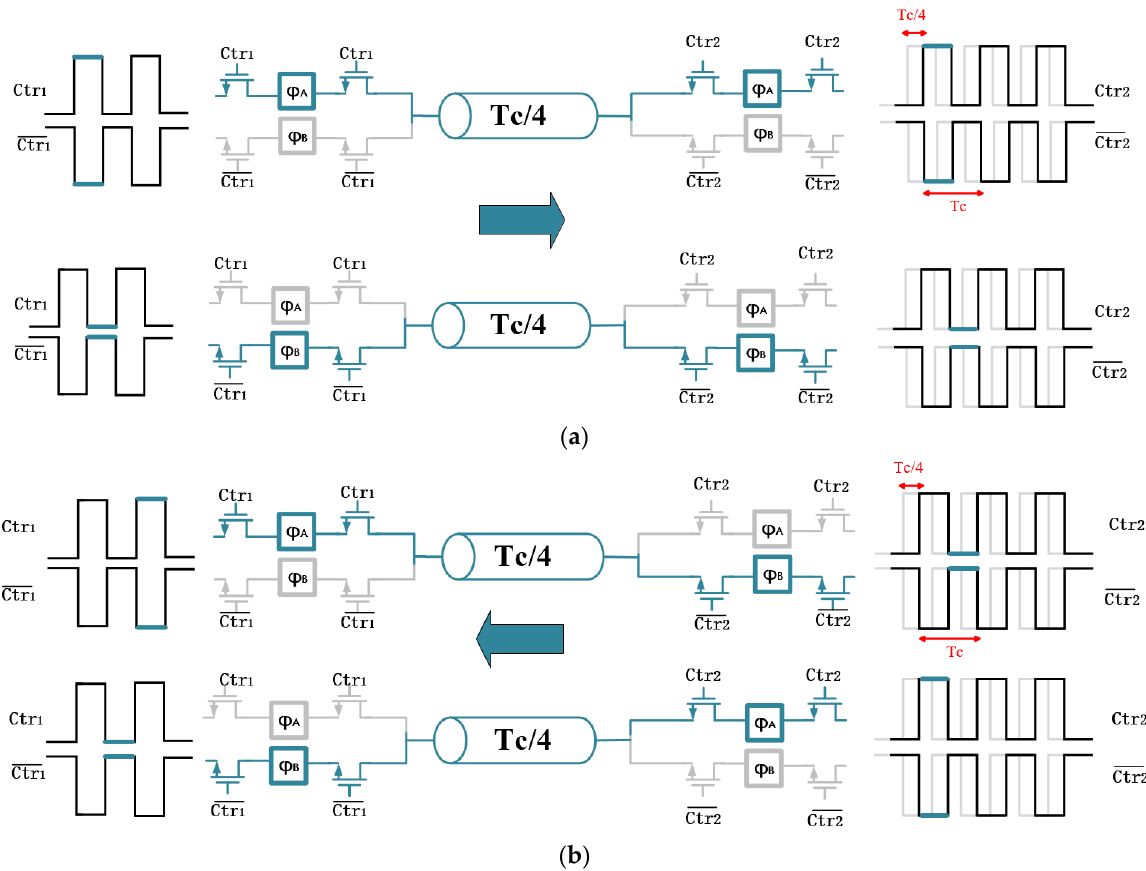
Figure 4. ( a ) Propagating transmission. ( b ) Opposite transmission.